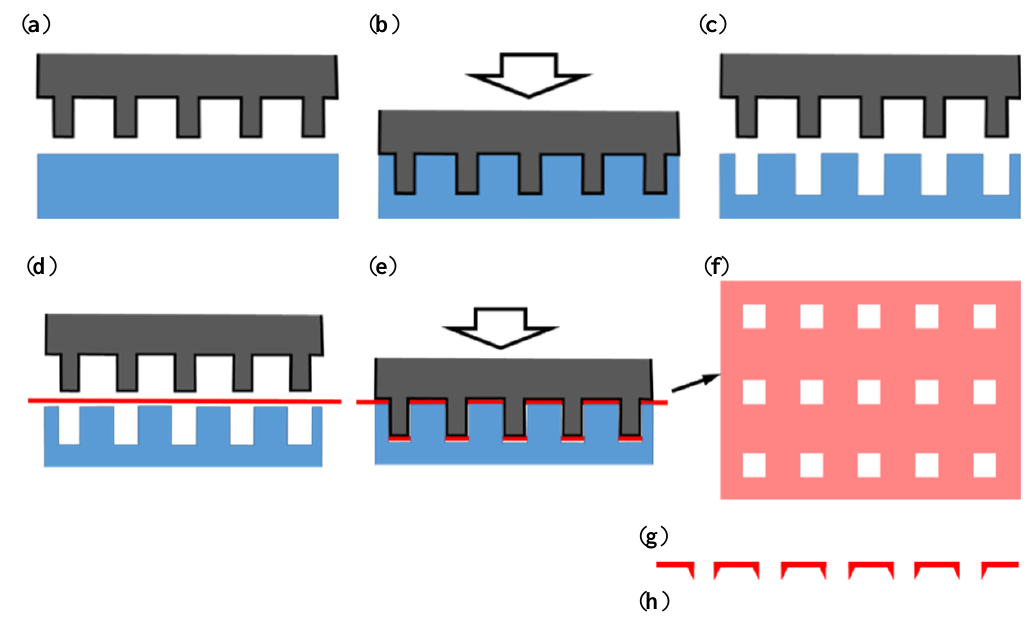
Figure 2. Processing steps for the microperforation of Ti sheets. ( a ) Fix a plastic resin plate on the workbench; ( b ) Compress MPNP into the plate; ( c ) Deform a die customized for engaging with MPNP; ( d ) Place a titanium sheet between MPNP and the die; ( e ) Punching; ( f ) The fabricated item after processing; ( g ) Head side; ( h ) Tail side.